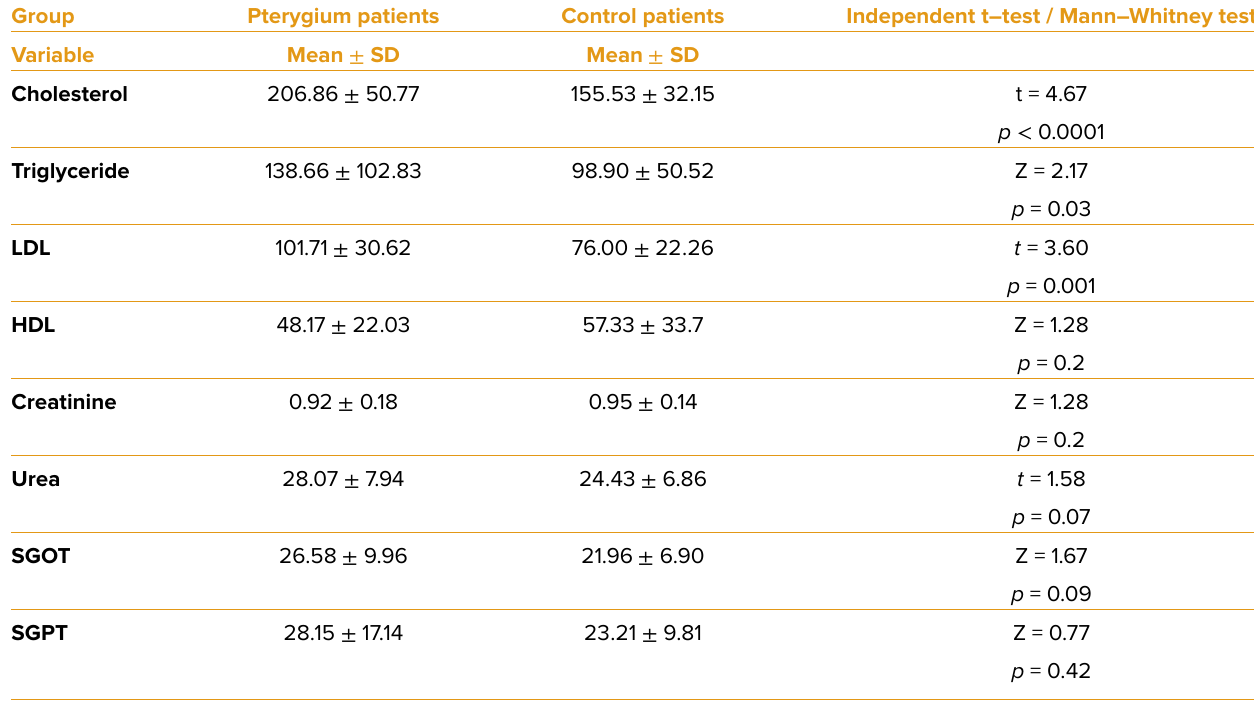
Table 3. Comparison of mean cholesterol, creatinine, urea, SGOT, SGPT, HDL, and LDL between the pterygium and control